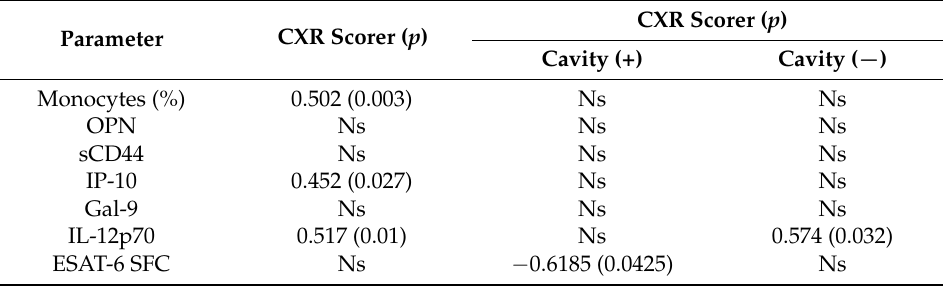
Table 6. CXR score and biomarkers in TB patients.